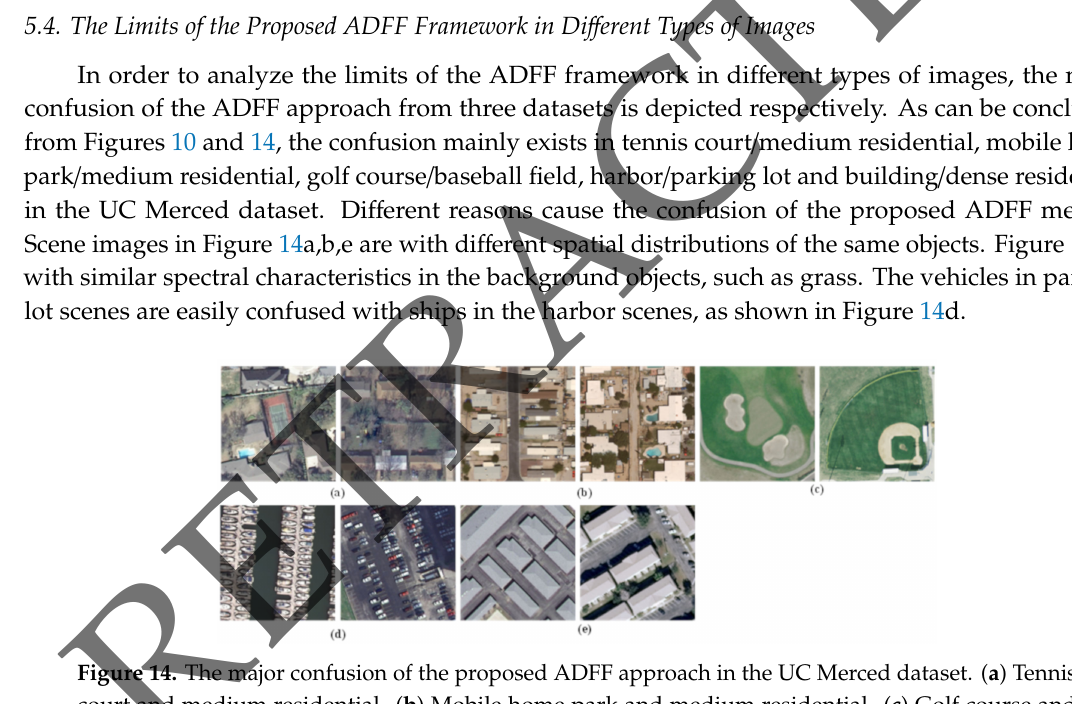
Figure 13. The attention maps of scene images derived from Grad-CAM. ( a ) The original scene image. ( b ) The Grad-CAM visualization results.